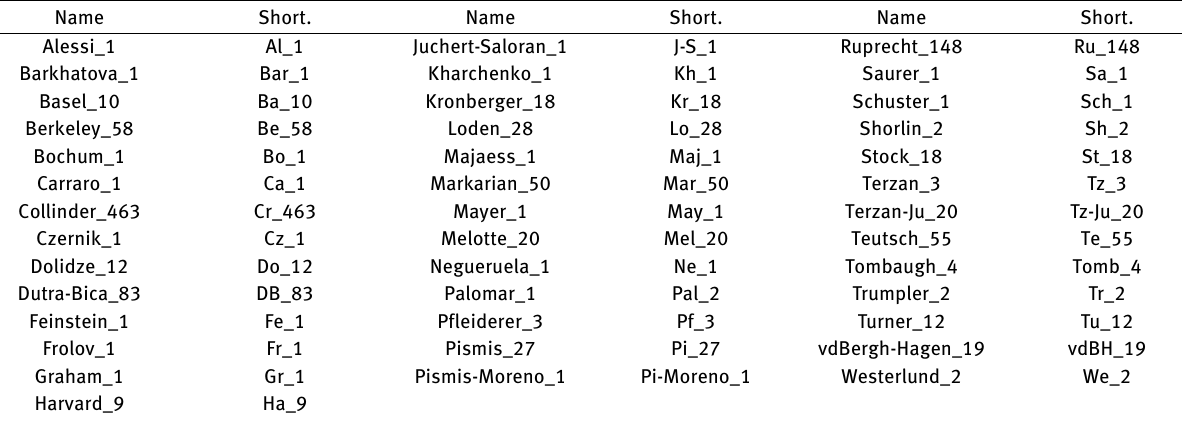
Table 2. The list of shortenings of cluster